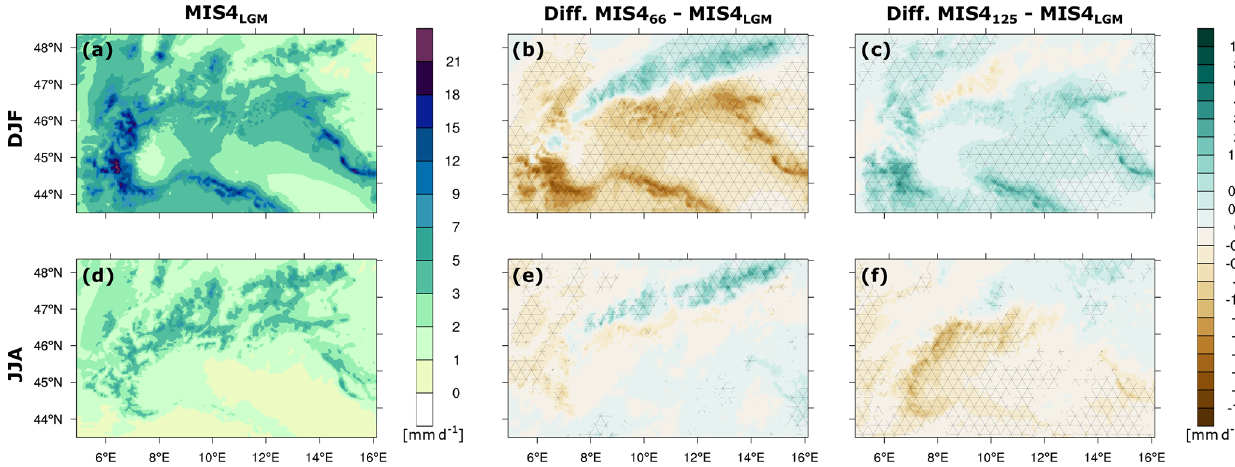
Figure 6. Climatological mean values of daily precipitation intensity over the Alps. Panel (a) represents MIS4 LGM precipitation for DJF, (b) the differences between MIS4 LGM66 and MIS4 LGM , (c) as panel (b) but between MIS4 LGM125 and MIS4 LGM . (d, e, f) As panels (a) , (b) and (c) but for JJA. Crosshatched areas indicate statistically significant differences at a significance level of 0.05 (using a two-tailed bootstrapping technique).